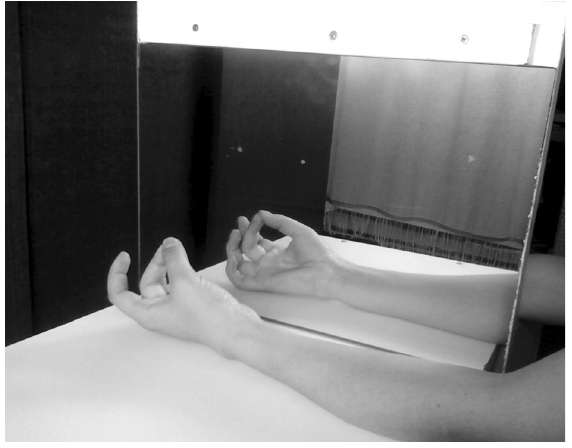
Figure 1. Mirror wall (38 cm x 33 cm) Measurements of muscle electrical